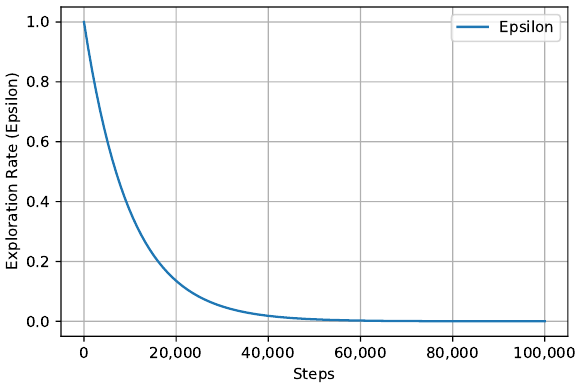
Figure 3. Epsilon value during learning.